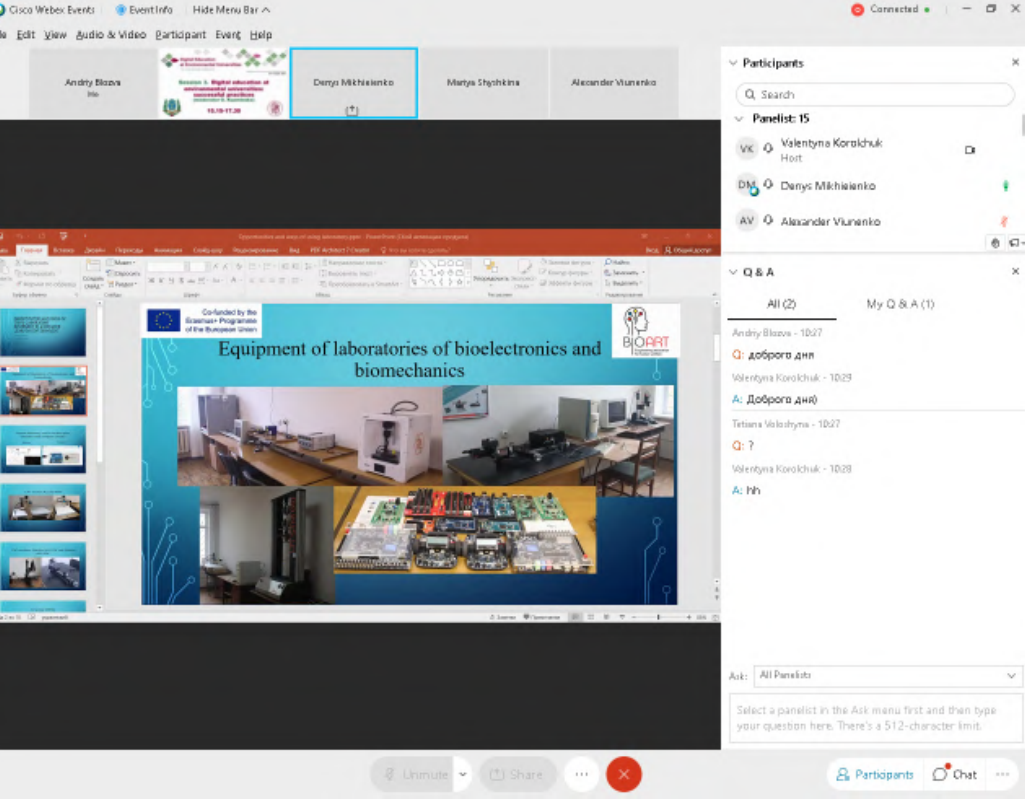
Figure 101: Presentation of paper